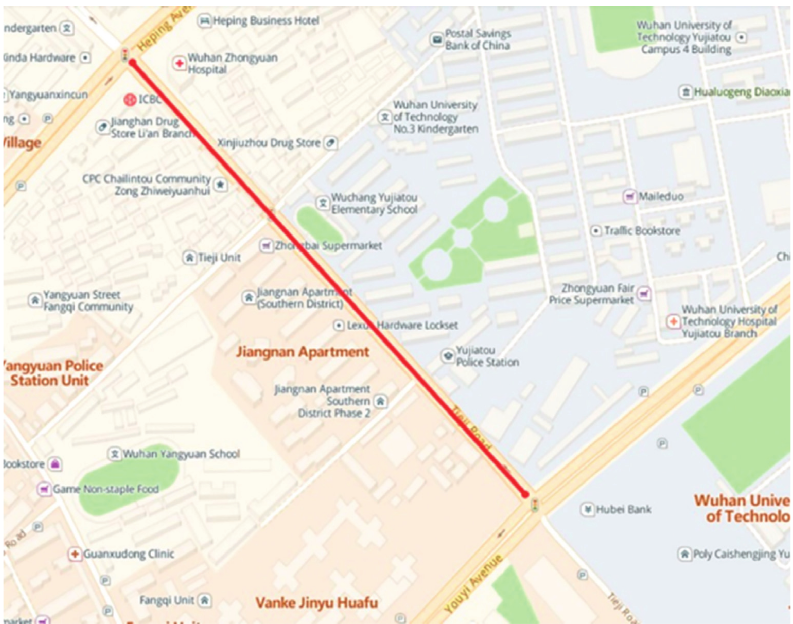
Figure 1: Details of the Tieji Road section. Table 1: Sample of the extracted GPS data preprocessed by pandas.